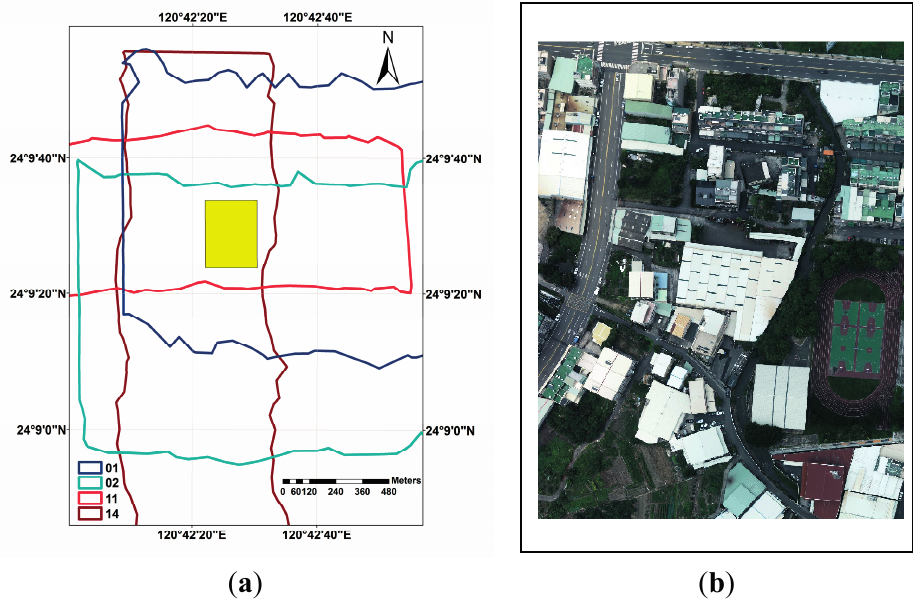
Figure 2. ( a ) Coverage of four overlapping strips over a homogeneous area. ( b ) Orthoimage of the study